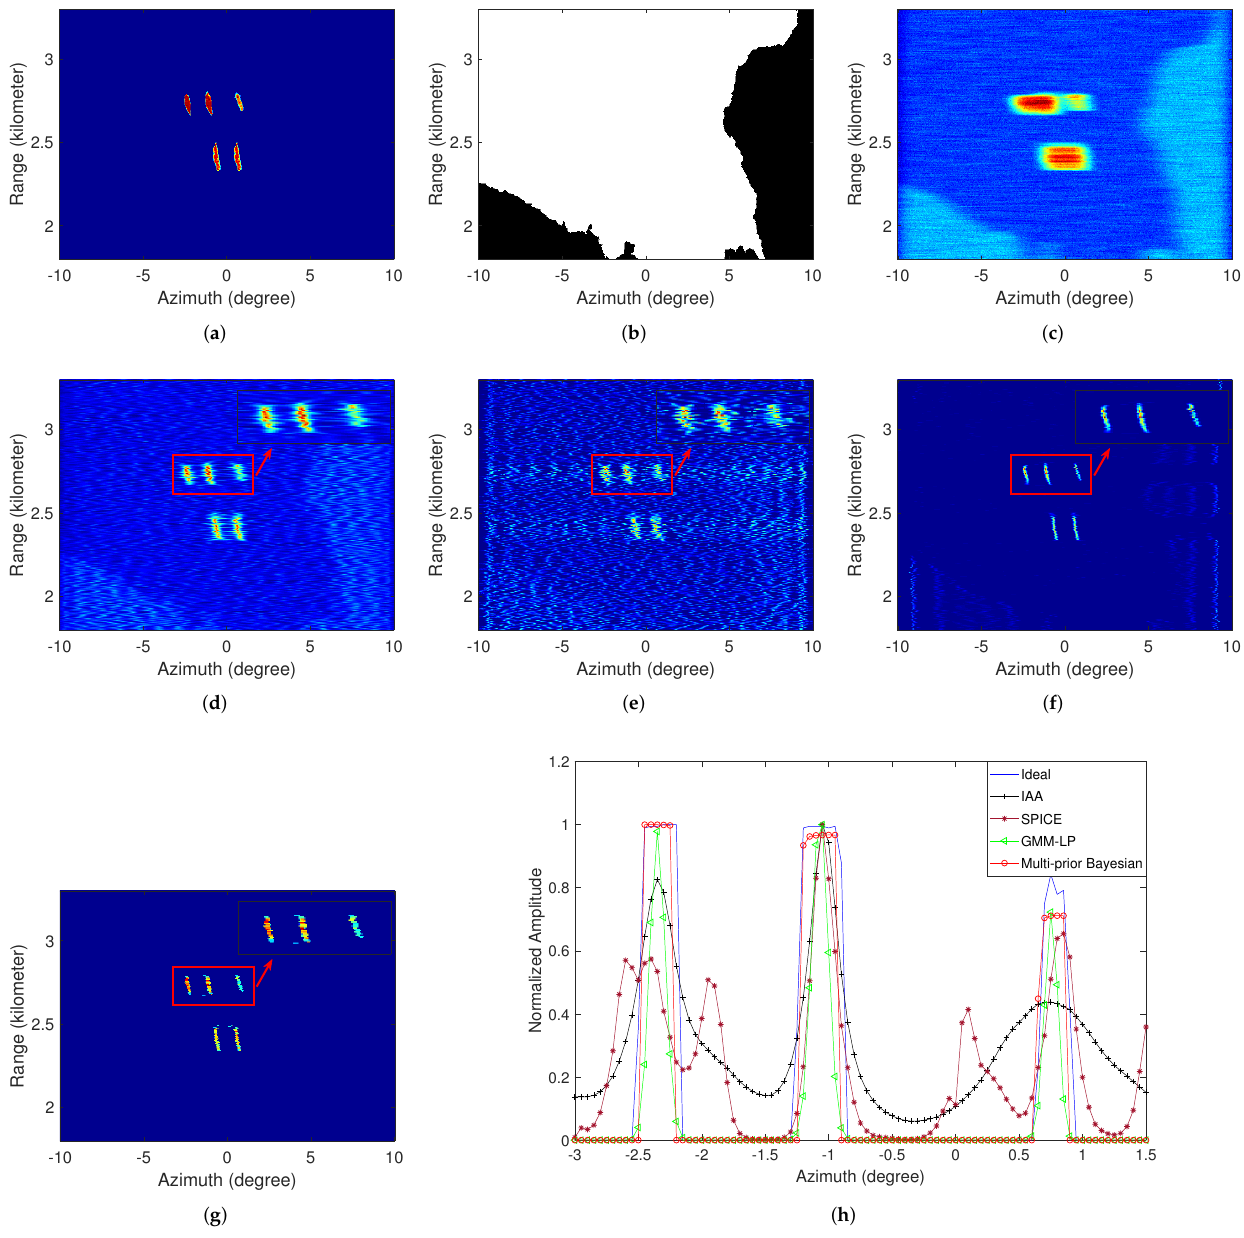
Figure 8. Area simulation results. ( a ) Ideal scene. ( b ) Clutter label. ( c ) Echo signal. ( d ) IAA method. ( e ) SPICE method. ( f ) GMM-LP method. ( g ) Multi-prior Bayesian method. ( h ) Comparison at range cell 2745